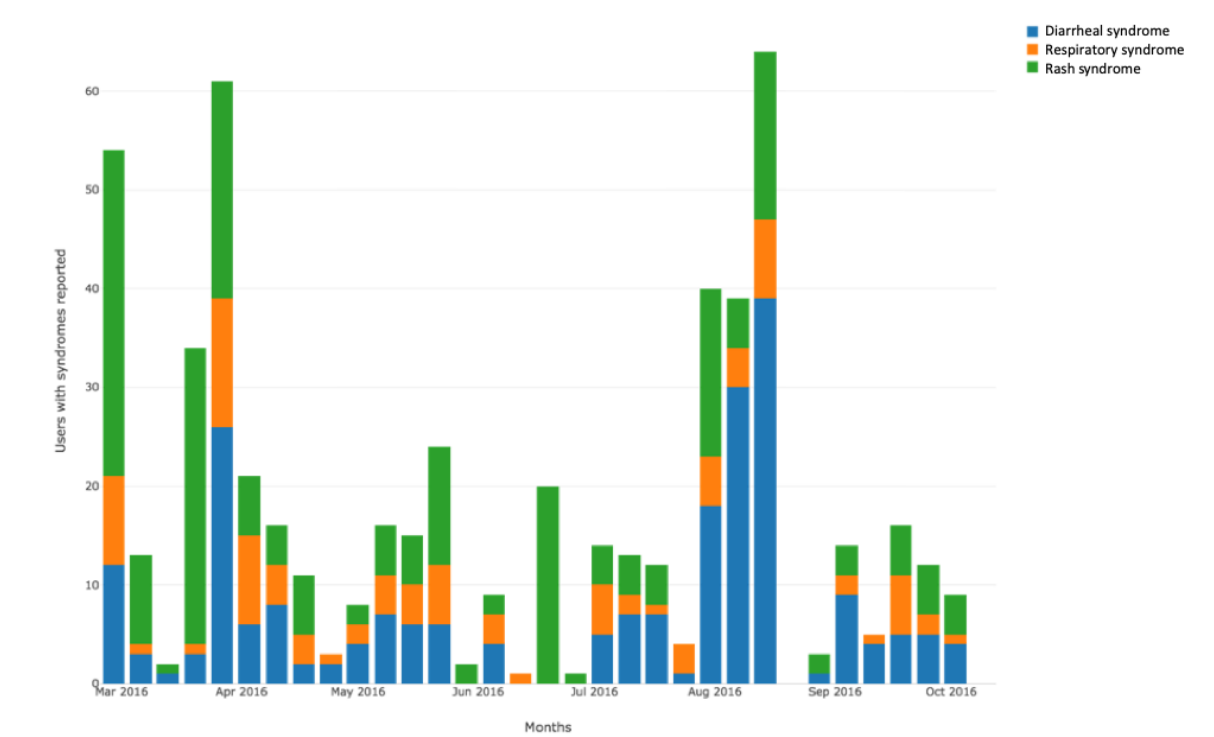
Figure 3. Temporal distribution for syndrome cases during the period of